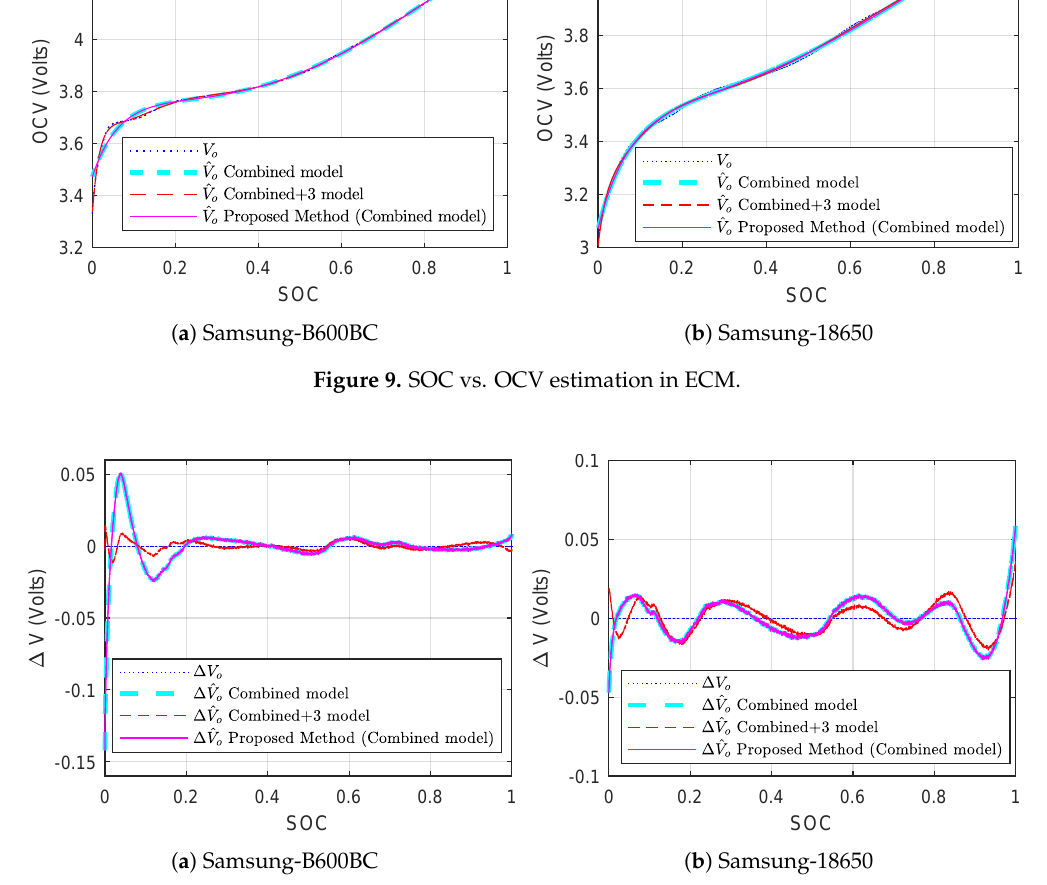
Figure 10. OCV estimation error in